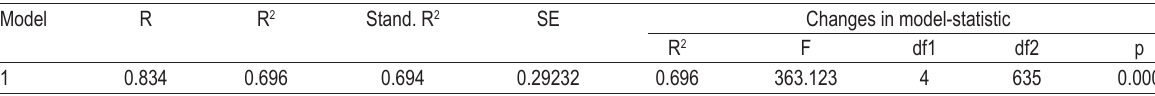
TABLE 6. Regression analysis of the risk assessment model Model